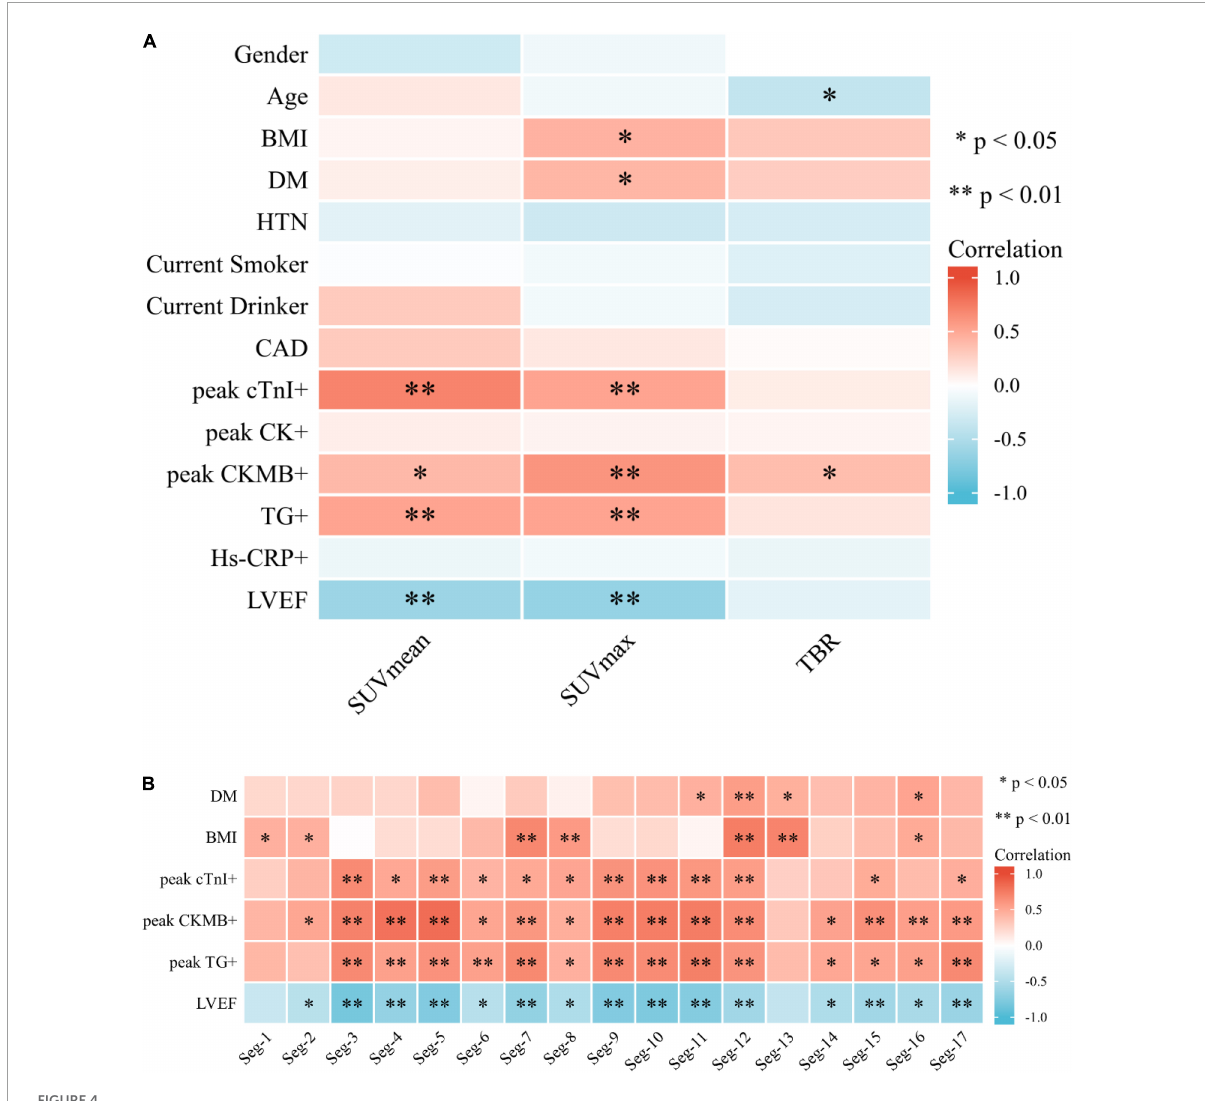
FIGURE4 (A) Heat map of cardiovascular risk factors, blood tests, and left ventricular ejection fraction associated with SUV uptake. BMI and DM demonstrated a correlation with SUVmax ( P < 0.05). Age showed a negative correlation with TBR ( P < 0.05). (B) Heat map of correlation analysis among SUVmax value of 17-segment of the left ventricle with DM, BMI, blood test, and